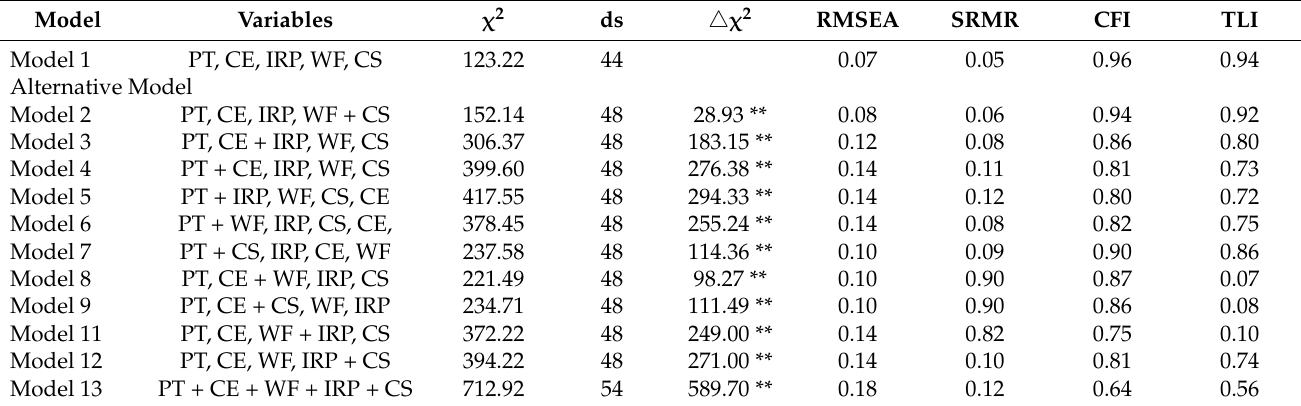
Table 1. Results of multilevel confirmatory factor analysis.